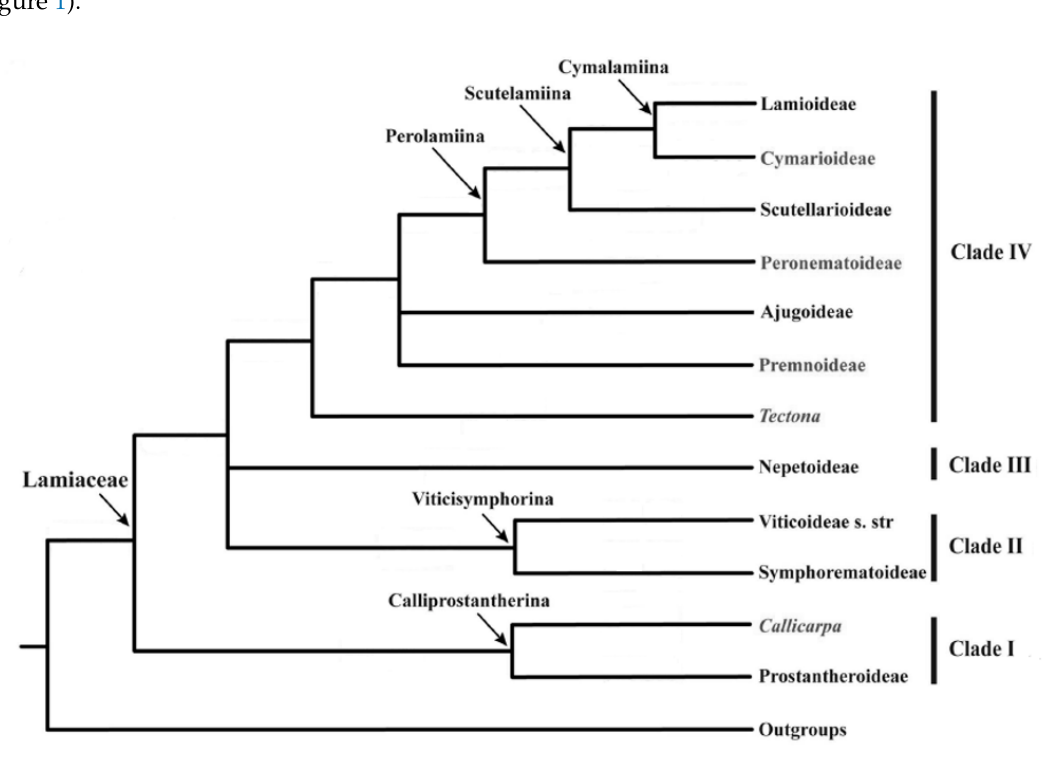
Figure 1. Phylogenetic diagram of Lamiaceae subfamilies (adapted from Li et al. [3]).